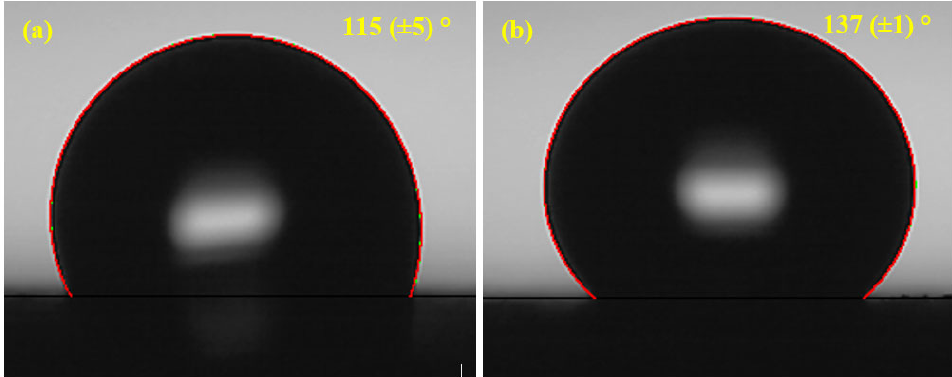
Figure 5. Contact angle of ( a ) Al and ( b ) Al-5 Mg coatings.